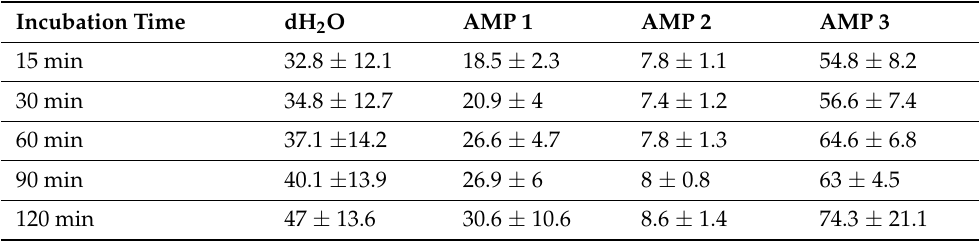
Figure 4. OD measurements at 405 nm (Y-axis) of free hemoglobin in a 1% human erythrocyte solution incubated for 15, 30, 60, 90 or 120 min at 37 ◦ C with PBS (negative control), 10% Triton X-100 (positive control), dH 2 O or AMPs 1, 2 or 3 (100 µ M). Average values from three experimental replicates, each containing two technical replicates, are presented with error bars (SD) included in plots. Table 4. Calculated hemolysis ratios according to Equation (1) for dH 2 O, AMPs 1, 2, and 3 (100 µ M) incubated (15–120 min) with a 1% human erythrocyte solution. Normalization was performed on data averaged from three biological replicates, each containing two technical replicates, using 10% Triton X-100 and PBS samples as positive and negative control,